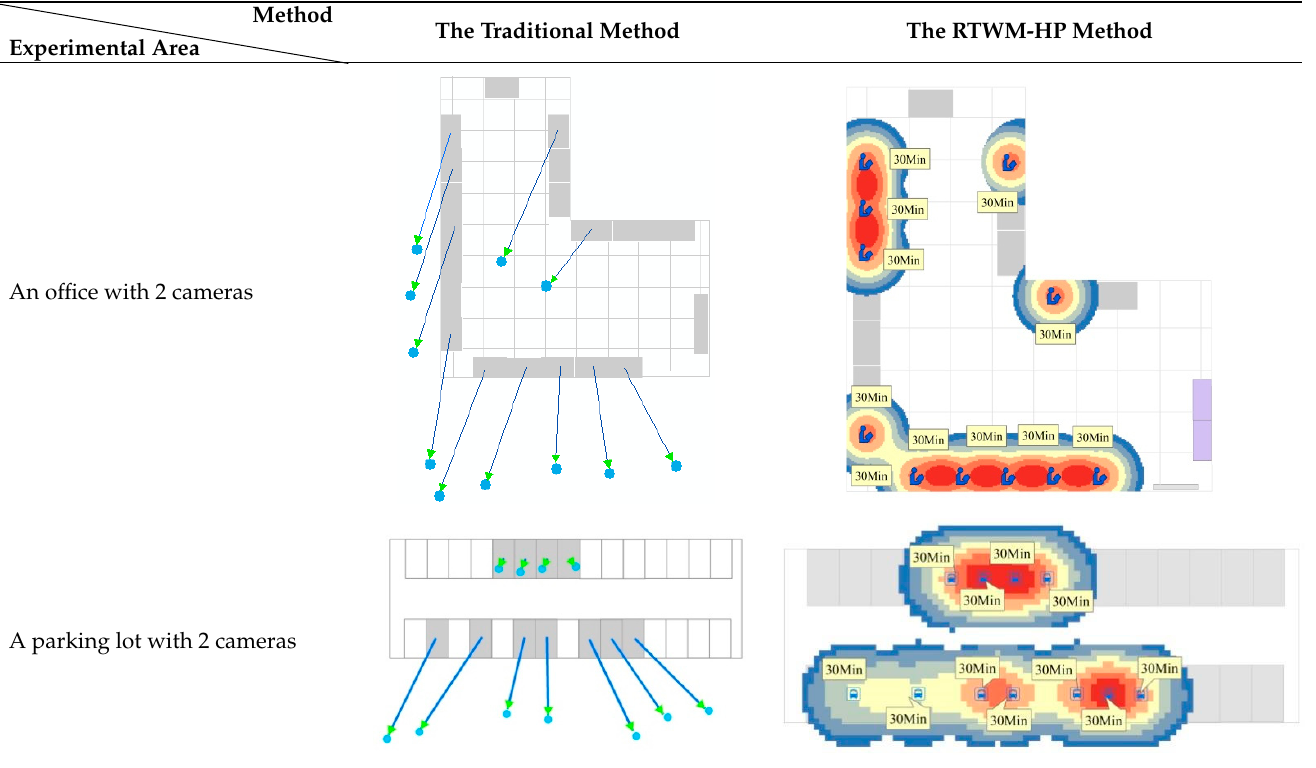
Table 4. The effects of real-time maps based on the traditional method and our method.